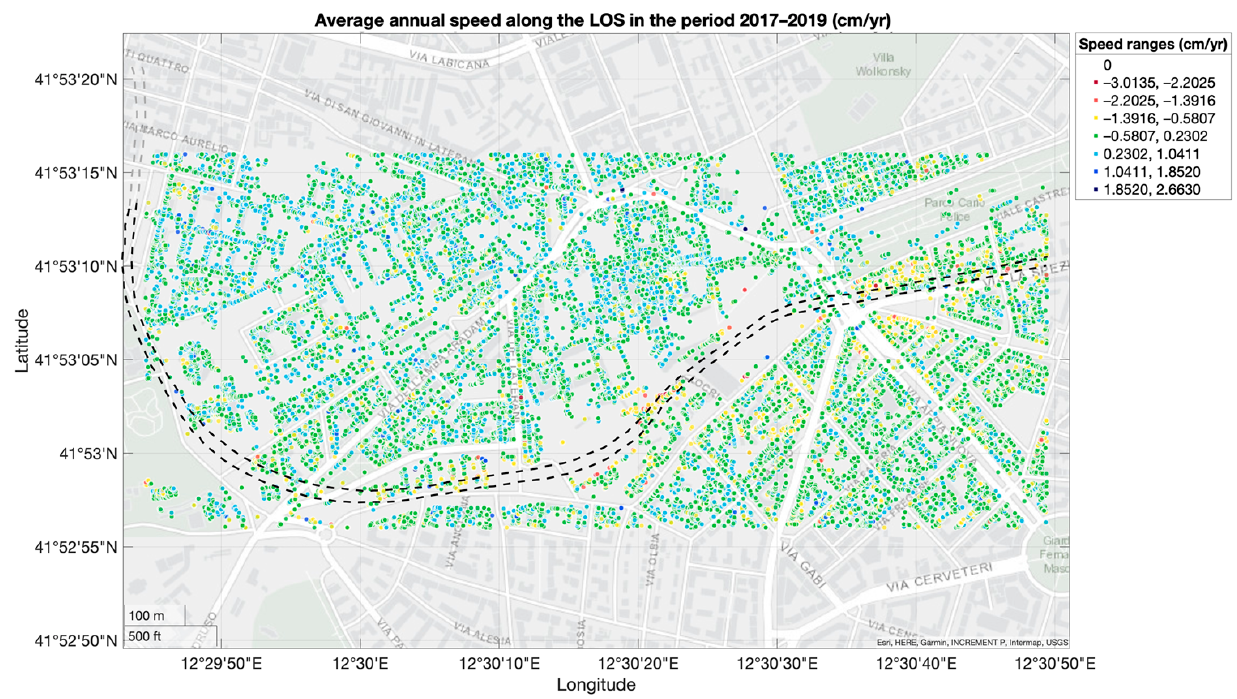
Figure 2. Map showing the T3 section of the Line C subway, the stations, the inter-tract shafts and the interaction with the other subway lines, Rome (Italy), edited from (https://goo.gl/maps/zPUUjveLSWBzj7nC9, accessed on 28 January 2022), [27].